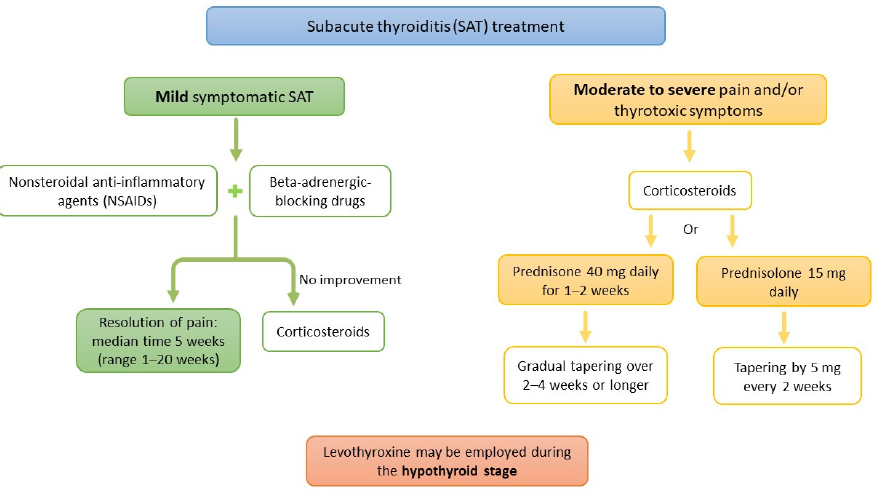
Figure 2. Therapeutic algorithm for the management of subacute thyroiditis (based on ATA recom- mendation [122]).